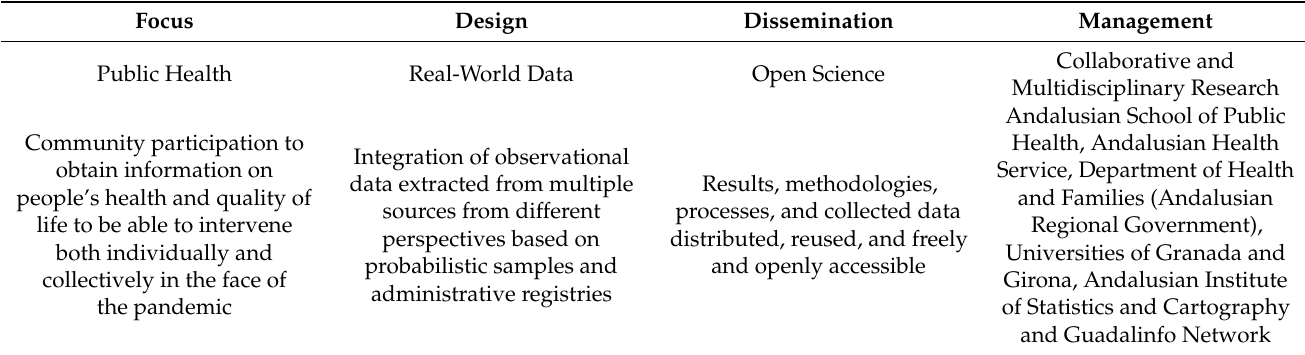
Table 1. Health Care and Social Survey (ESSOC): Study